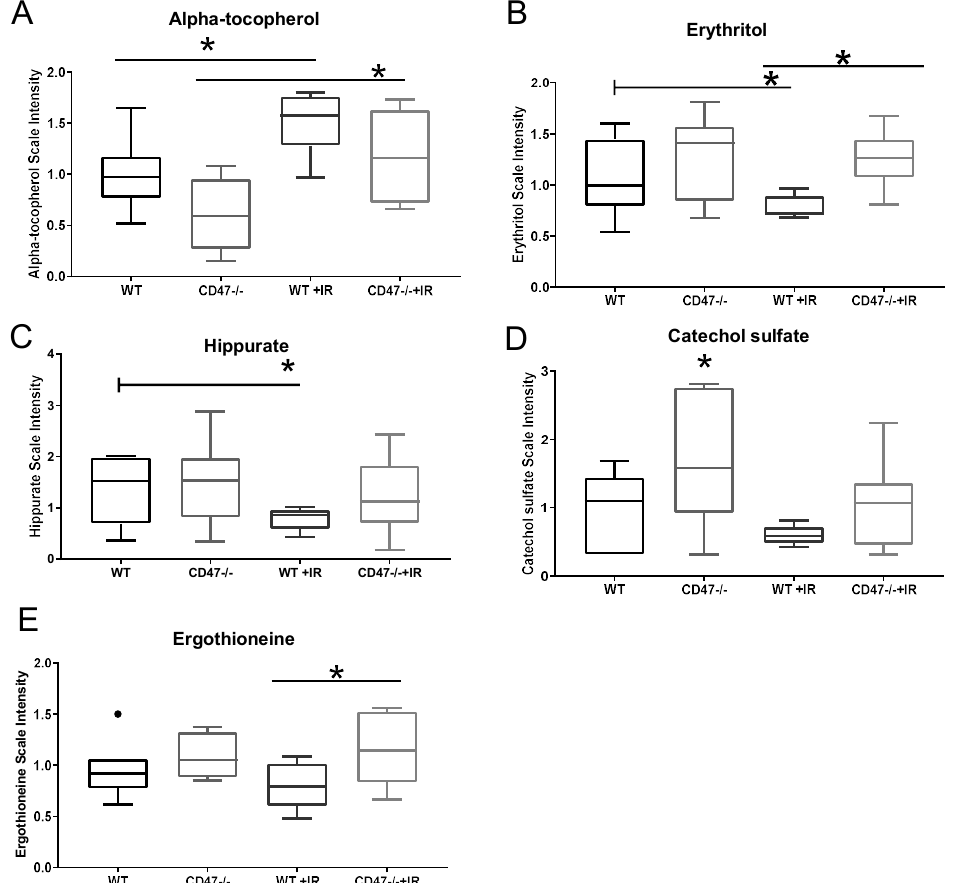
Figure 6. Regulation of nutrient and xenobiotic metabolite processing after exposure to ionizing radiation. ( A ) alpha-tocopherol, ( B ) Erythritol, ( C ) Hippurate, ( D ) Catechol sulfate and ( E ) Ergothioneine metabolites were measured in lungs of mice with or without whole body irradiation. Symbols denote outliers. (* p < 0.05, n = 7–8).